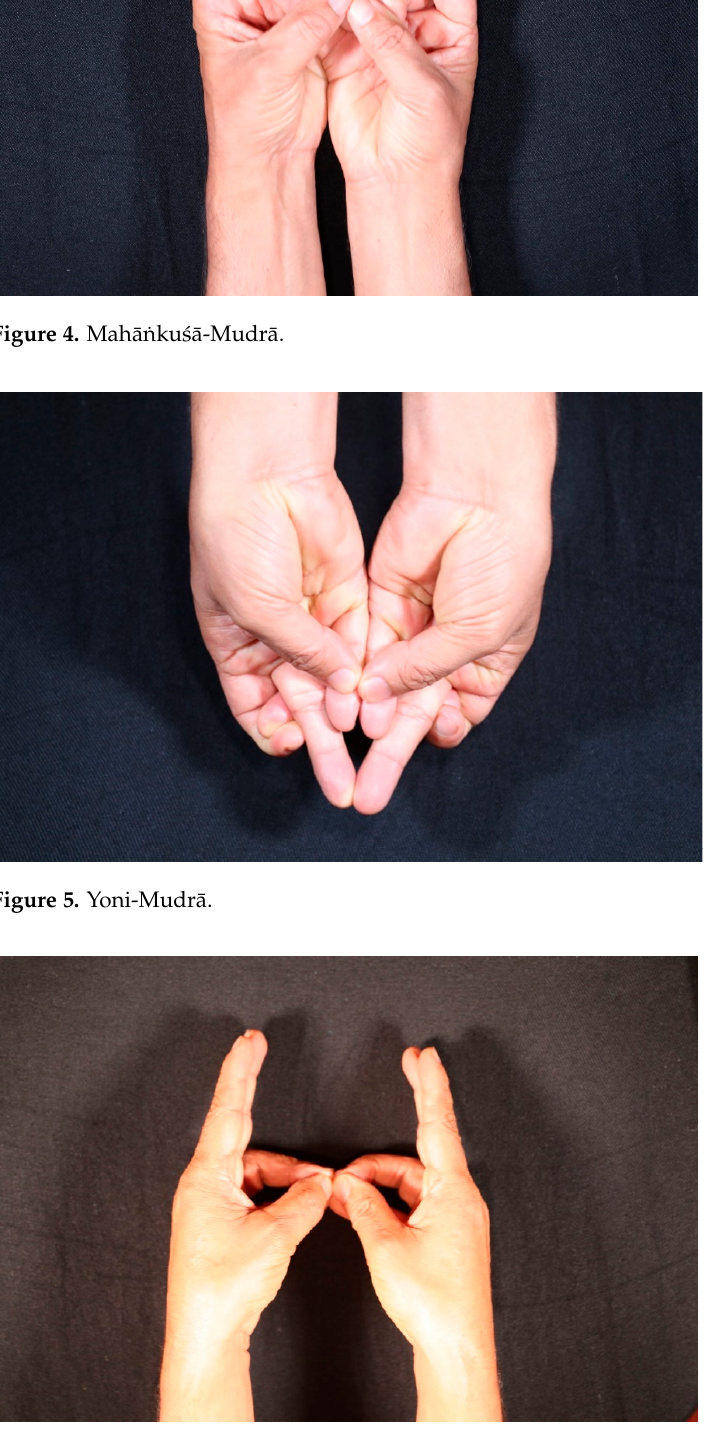
Figure 6. Vidr ā vi ṇ ī -Mudr ā .